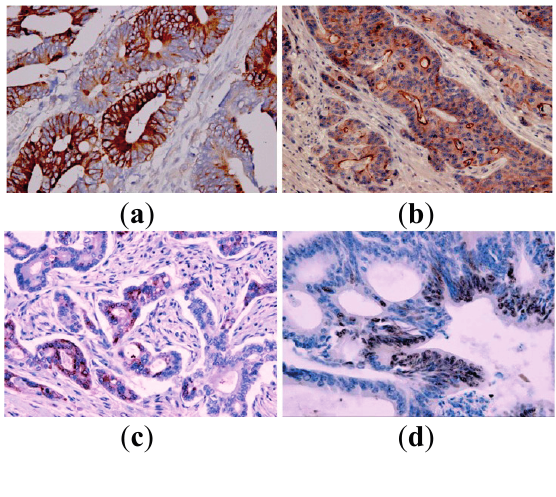
Figure 1. Representative images of immunohistochemical staining for carboxylesterase 2 (CES2), breast cancer resistance protein 2 (ABCG2), thymidylate synthase (TS) and Topo-I in tissues of metastatic colorectal cancer (original magnification 200×). ( a ) Positive cytoplasmic CES2 expression; ( b ) Positive membranous and cytoplasmic ABCG2 expression; ( c ) Positive cytoplasmic TS expression; ( d ) High nuclear Topo-I